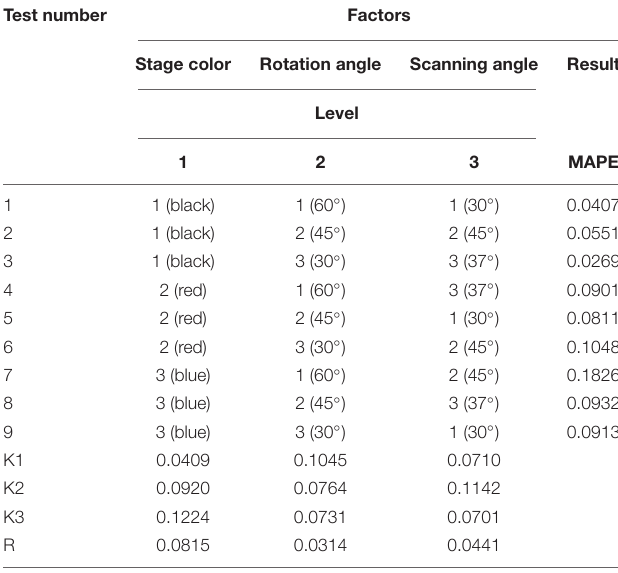
TABLE 3 | Orthogonal experimental results based on L9 (3ˆ4) orthogonal